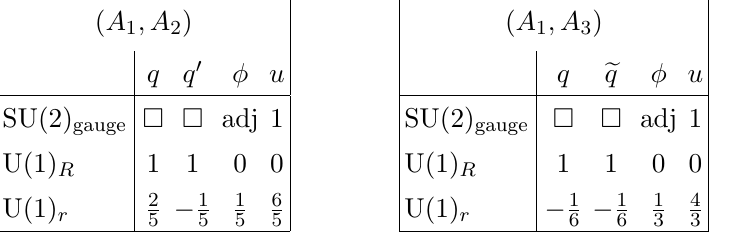
Table 7 . Field content of 4d N = 1 Lagrangian theories that (cid:13)ow to ( A 1 ; A 2 ) and ( A 1 ; A 3 ) Argyres-Douglas